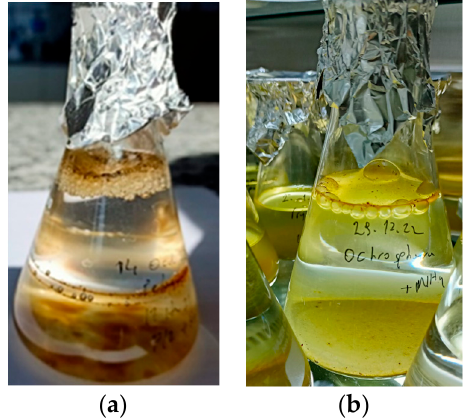
Figure 4. ( a ) Mucilage formation at the surface layer of the flask when Ochrosphaera neapolitana was cultured together with two different diatom species (2 weeks old) and ( b ) mucilage formation in monospecific Ochrosphaera neapolitana culture (2 weeks old).